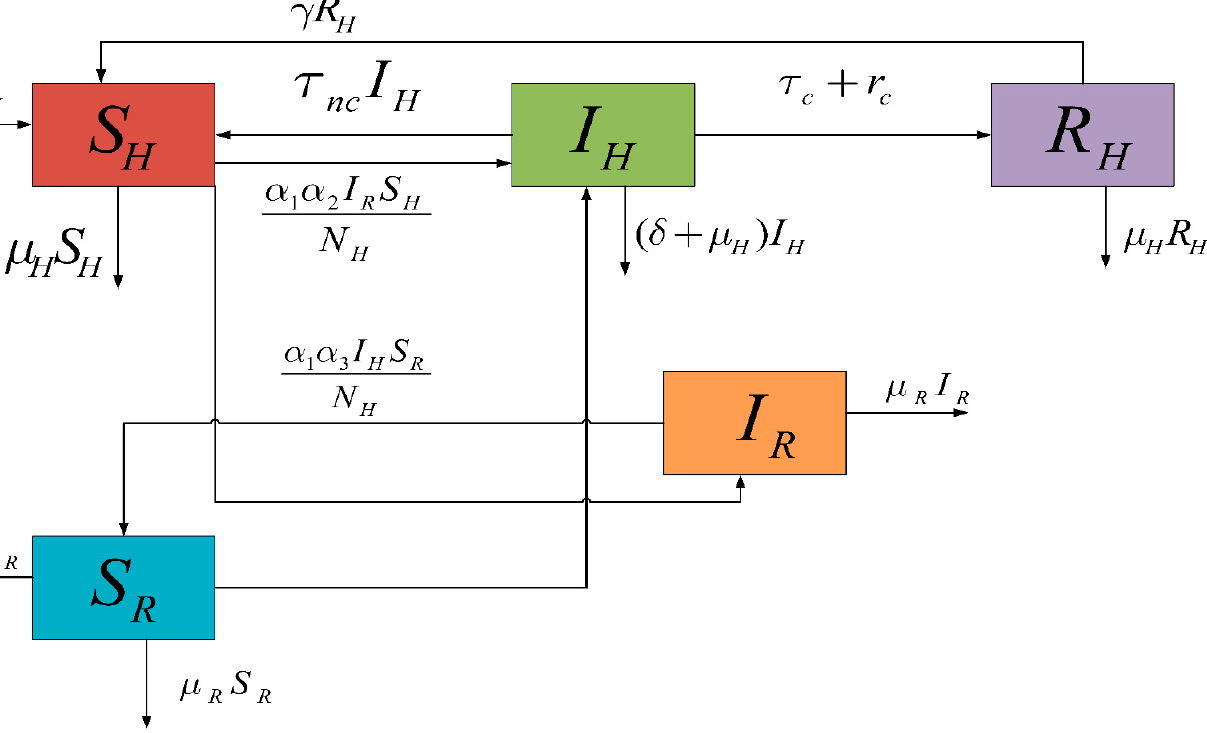
Figure 1. Flow chart of Lassa fever model.